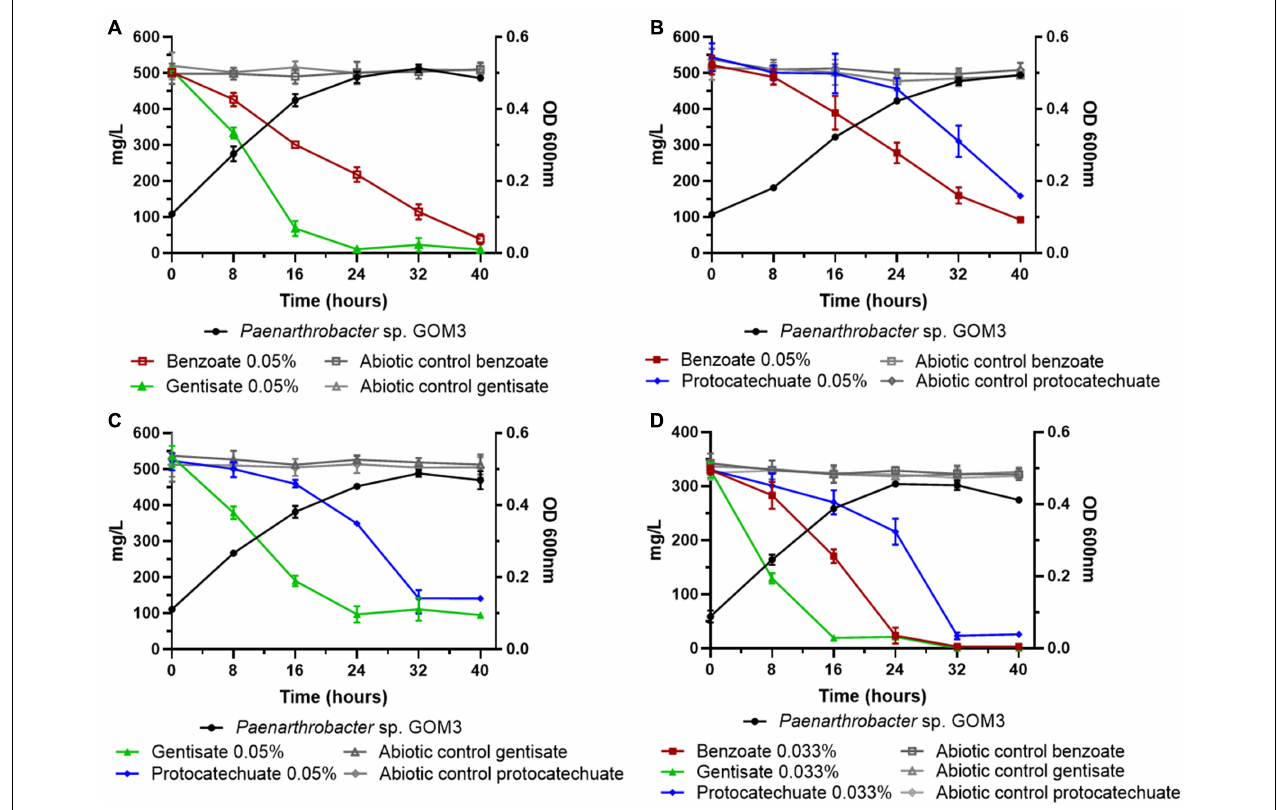
FIGURE 4 | Substrate decrease and growth kinetics of Paenarthrobacter sp. GOM3 in the presence of different mixtures of aromatic compounds (A) benzoate and gentisate, (B) benzoate and protocatechuate, (C) gentisate and protocatechuate and (D) the three compounds. Whiskers represent the standard deviation of three biological replicates. Aromatic compound in abiotic controls in